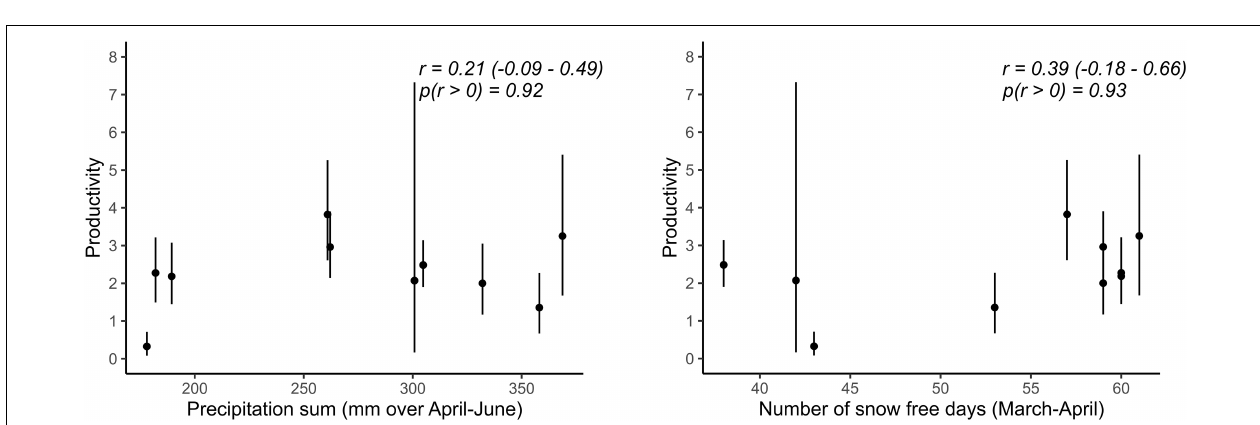
FIGURE 1 | Annual population growth rate, adult and juvenile apparent survival probabilities for two ring ouzel populations in the Alps. Annual productivity parameters were also obtained for the Vercors population, whereas only the average productivity was estimated in the Valais population. Error bars represent 95% credible intervals